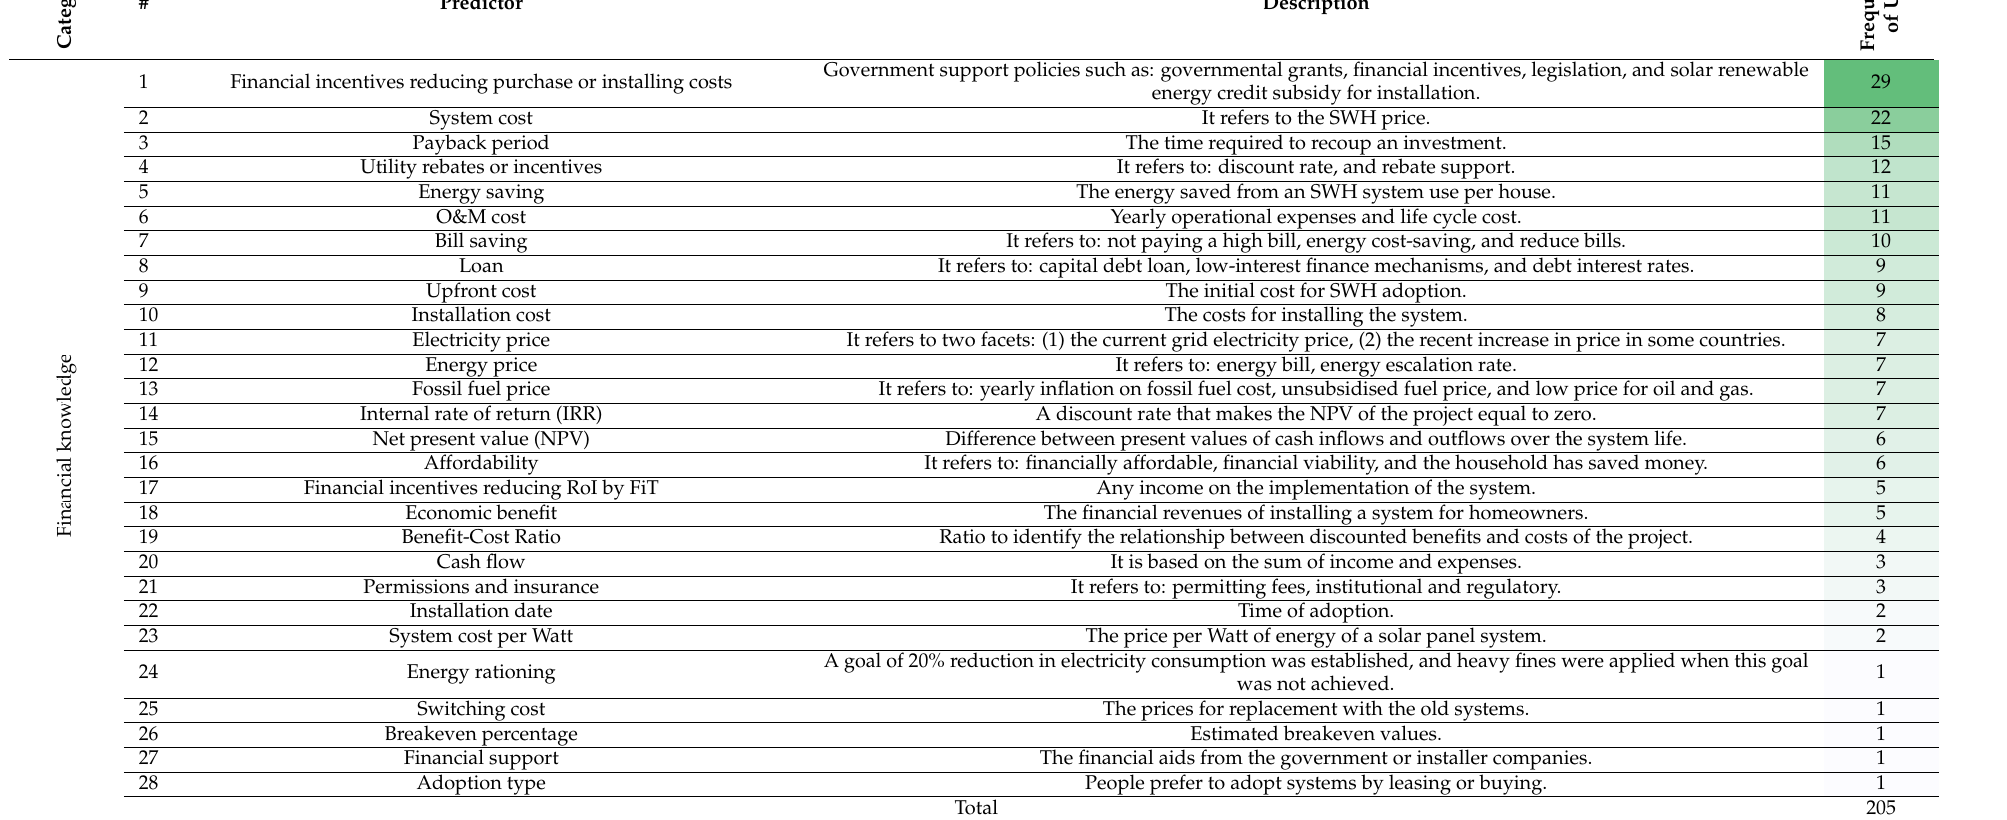
Table A1. Financial characteristics of household adoption of solar systems. The green colour of the numbers in front of each predictor indicates their use frequency. Darker colour = more common in